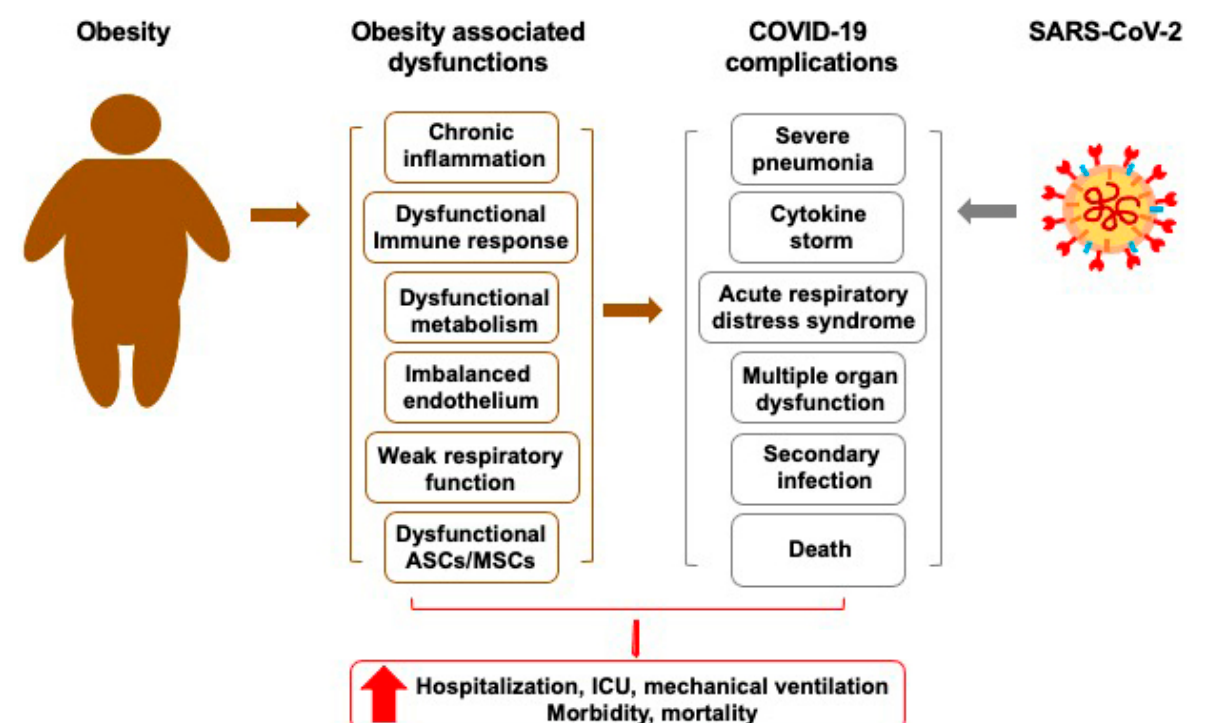
Figure 2. Schematic illustration of how obesity influence the development of COVID-19. Multiple pathological features of obesity, such as systematic chronic inflammation and dysfunctionality in ASCs/MSCs, immune response, metabolism, and endothelium, affect the progression and outcomes of COVID-19.